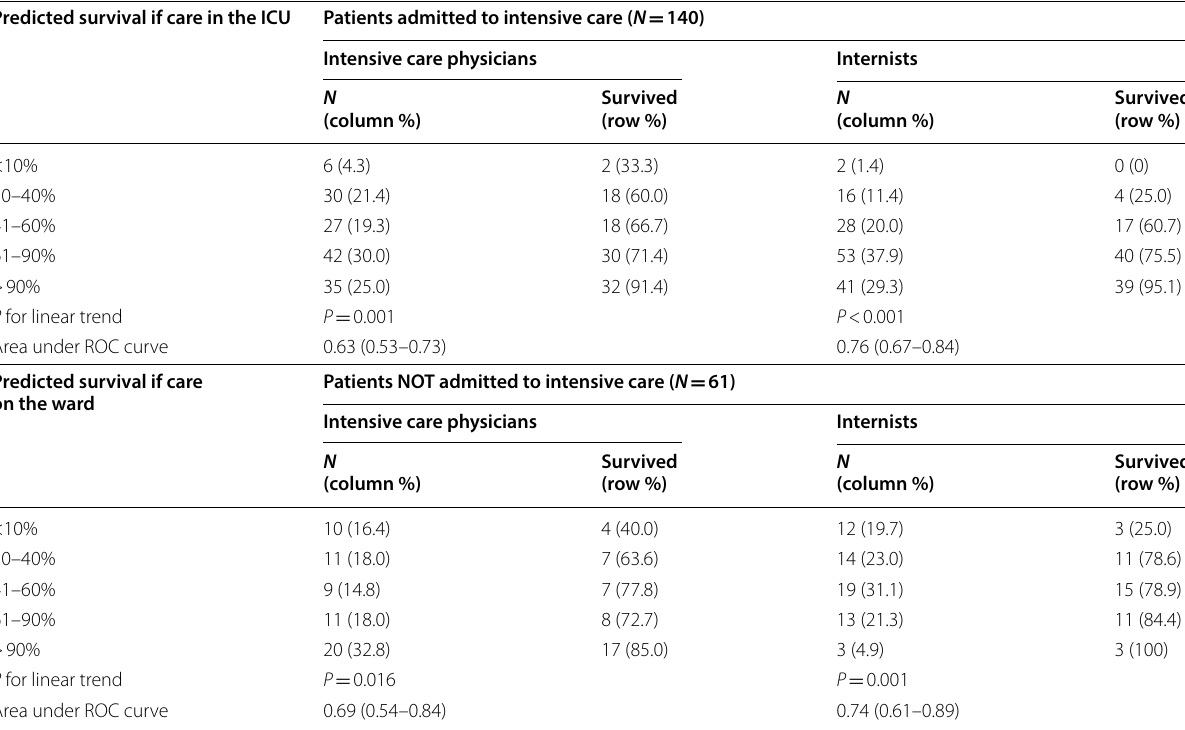
Table 4 Patients’ observed 28 day survival according to physicians’ survival predictions Predicted survival if care in the ICU Patients admitted to intensive care ( N